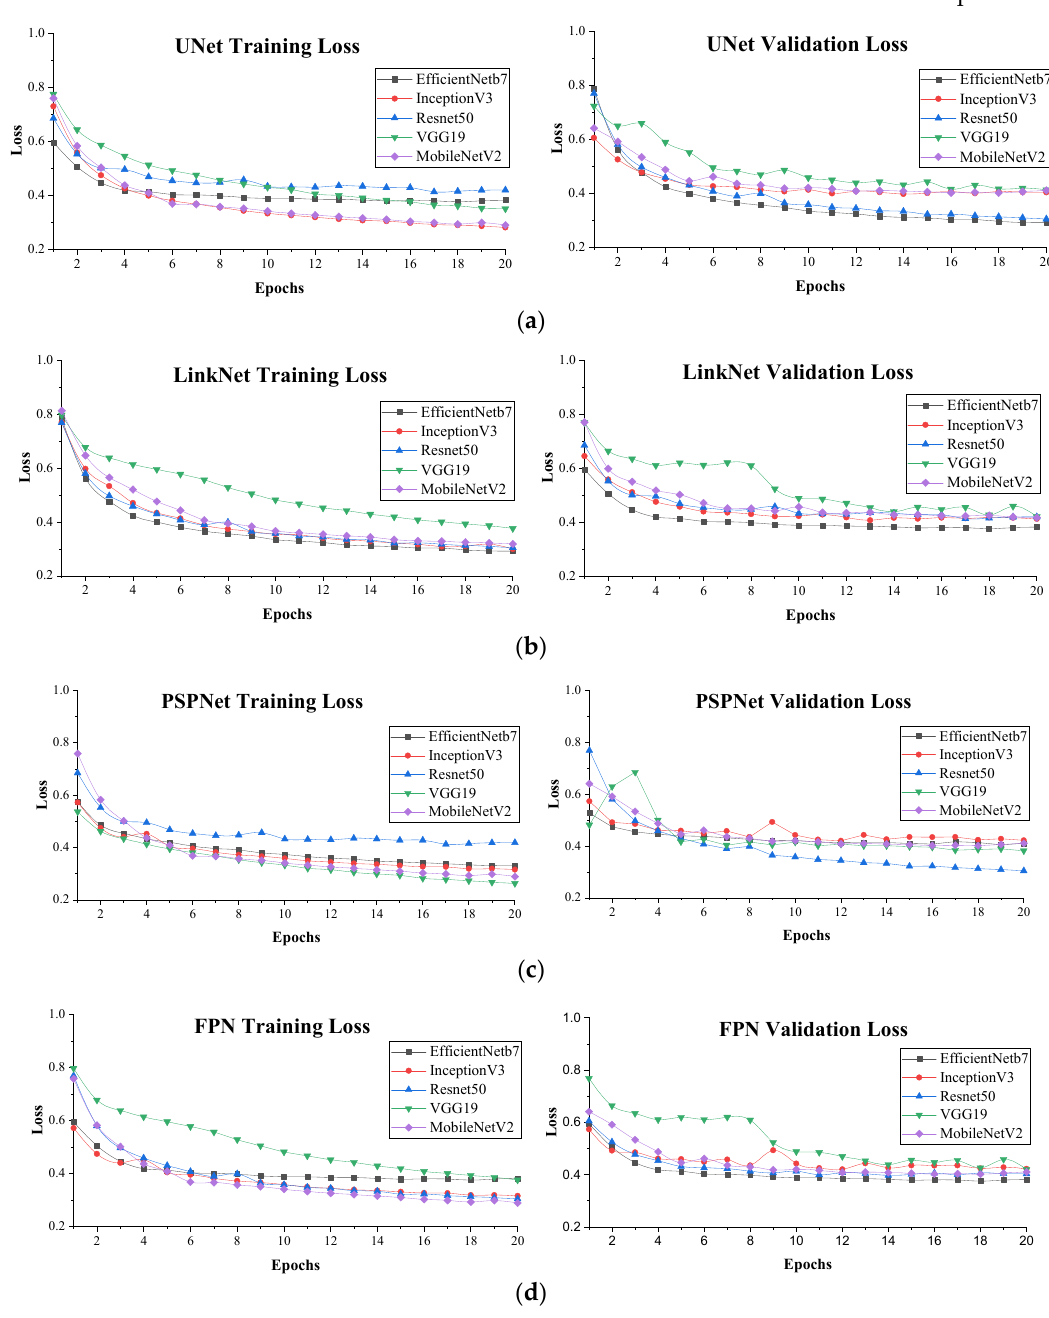
has achieved satisfactory results in an unstructured environment with high-traffic areas. class for the ensembled model on the test dataset. The results are also presented in Table 5.